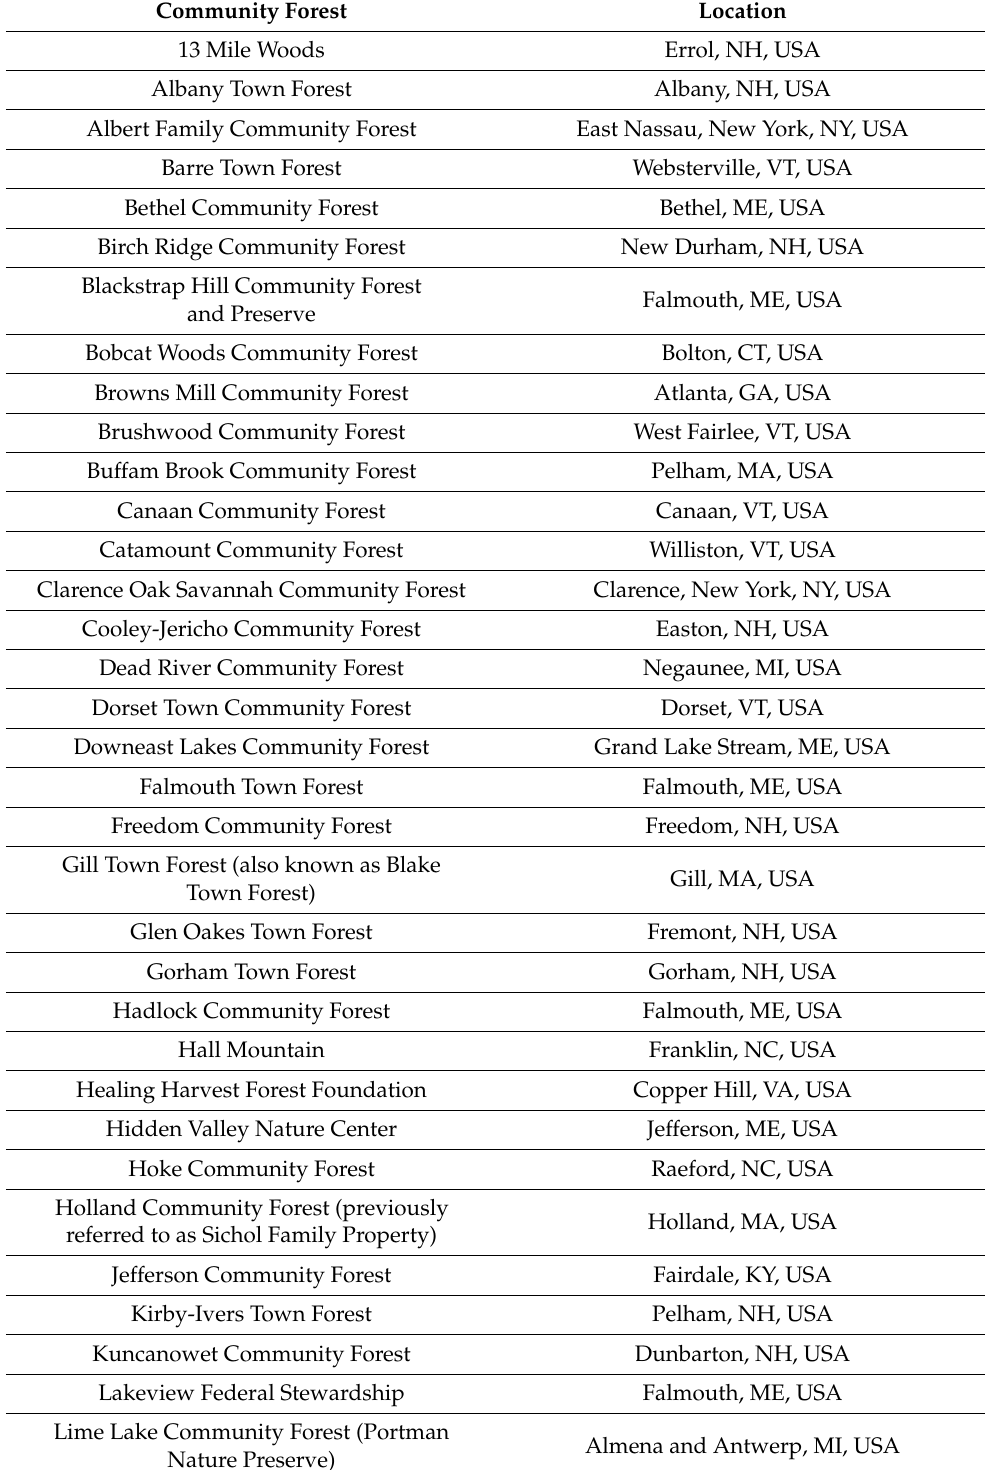
Table A2. List of eastern U.S. community forests identified through an online